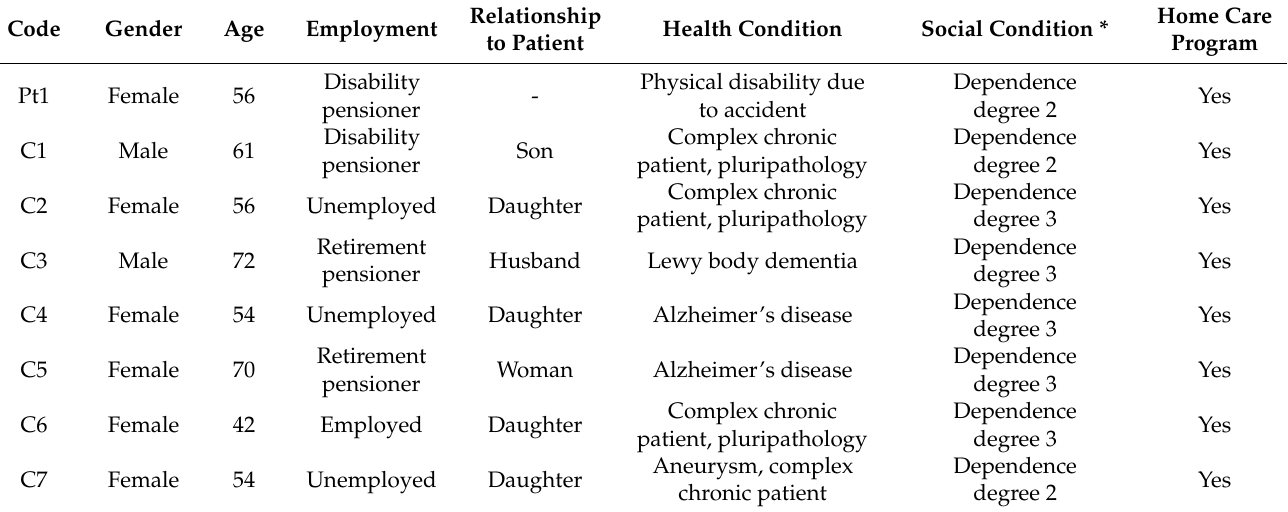
Table 2. Characteristics of users (caregivers and patients)